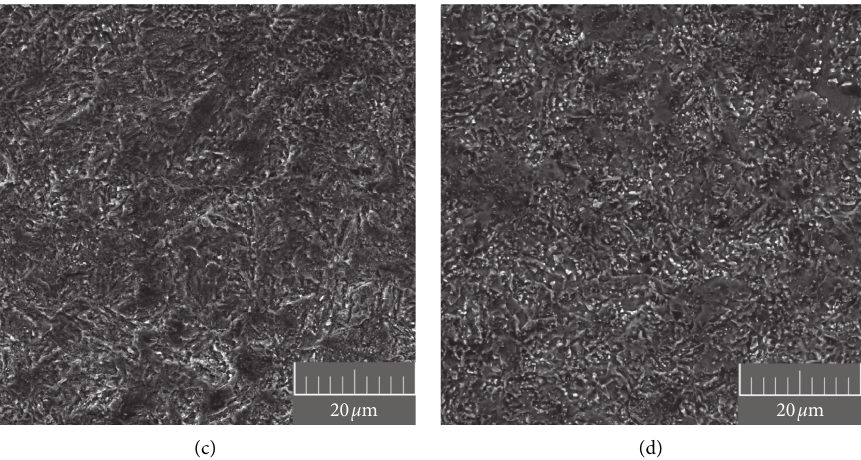
Figure 11: SEM micrographs of fracture surfaces of (a) CHTspecimen and CTspecimens treated for (b) 2h (CT7), (c) 12h (CT8), and (d) 24h (CT9) at − 196 ° C.